Question: What visual encoding does this figure use to show its data?
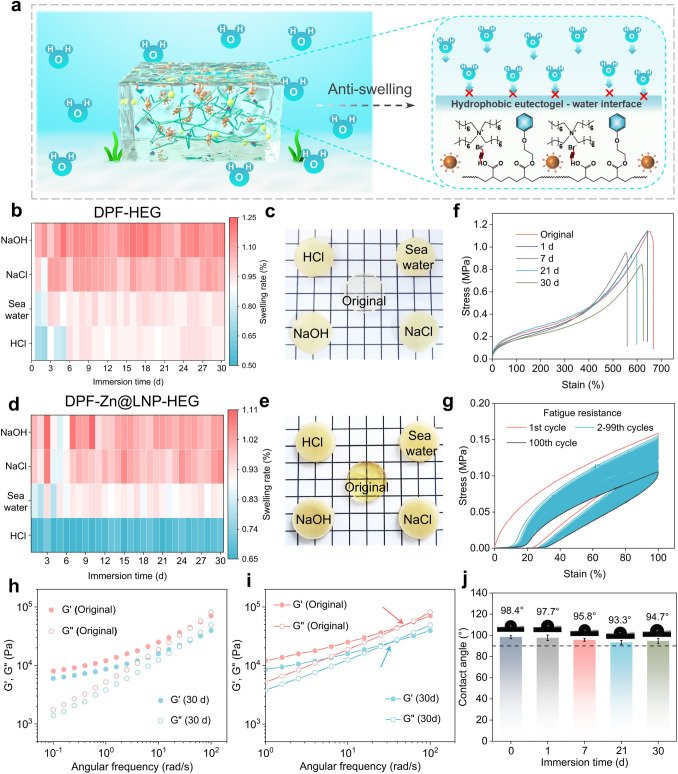
Answer: line